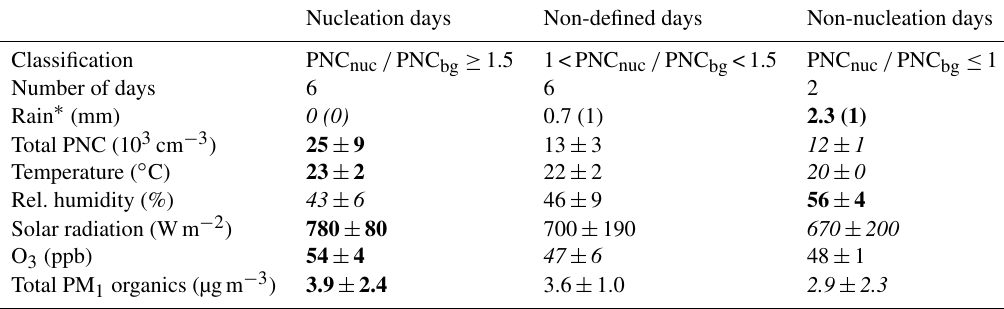
Table 6. Variables measured during DIAPASON2014 indicating different ambient conditions on days classified as nucleation, non-defined and non-nucleation days. Total particle number concentrations (PNCs) and the classification criteria and number of respectively classified days are also listed. For each measurement day and presented variable, daily averages for the period 10:00–16:00 were calculated. Here, the mean and standard deviation of these averages are shown with maximum values in bold and minimum values in italic.